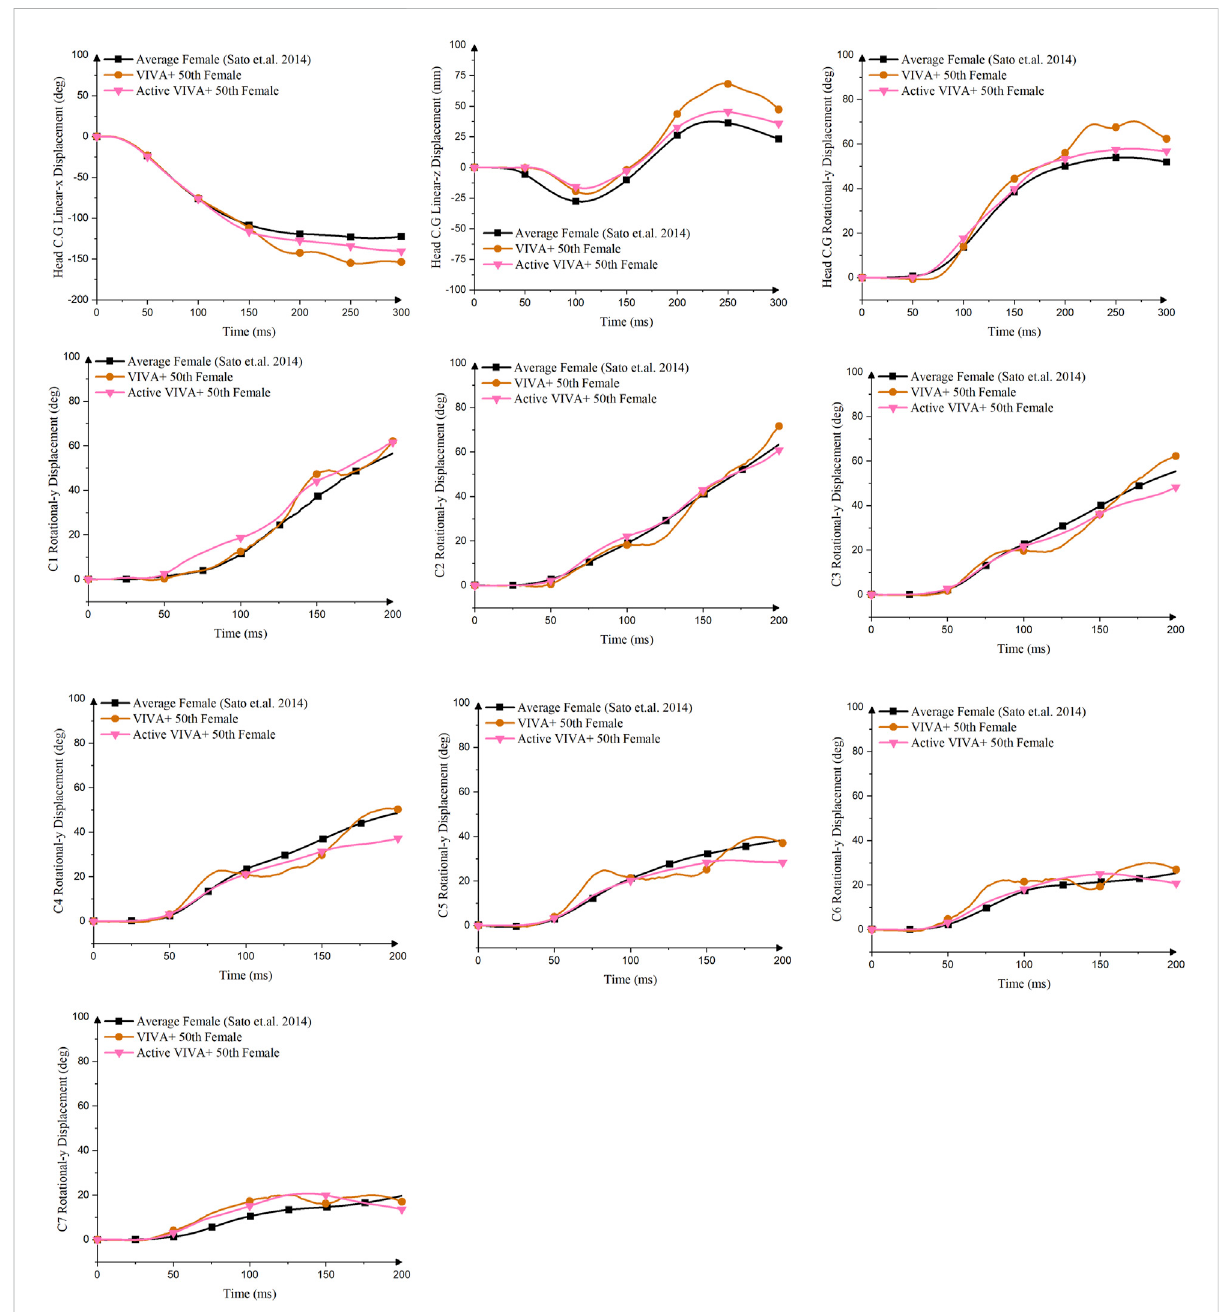
FIGURE 5 Comparison of Head C.G and Cervical Vertebra C.G linear and rotational displacements between Original VIVA+ Female Model, Active (PSV + PDE + CCo + APF) Female VIVA+ Models and Volunteer Kinematics from Sato et al. (2014) 5.8